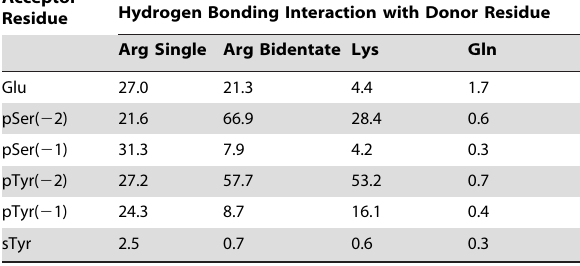
Table 1. Hydrogen Bond Occupancies in Molecular Dynamics Simulation of Tripeptide